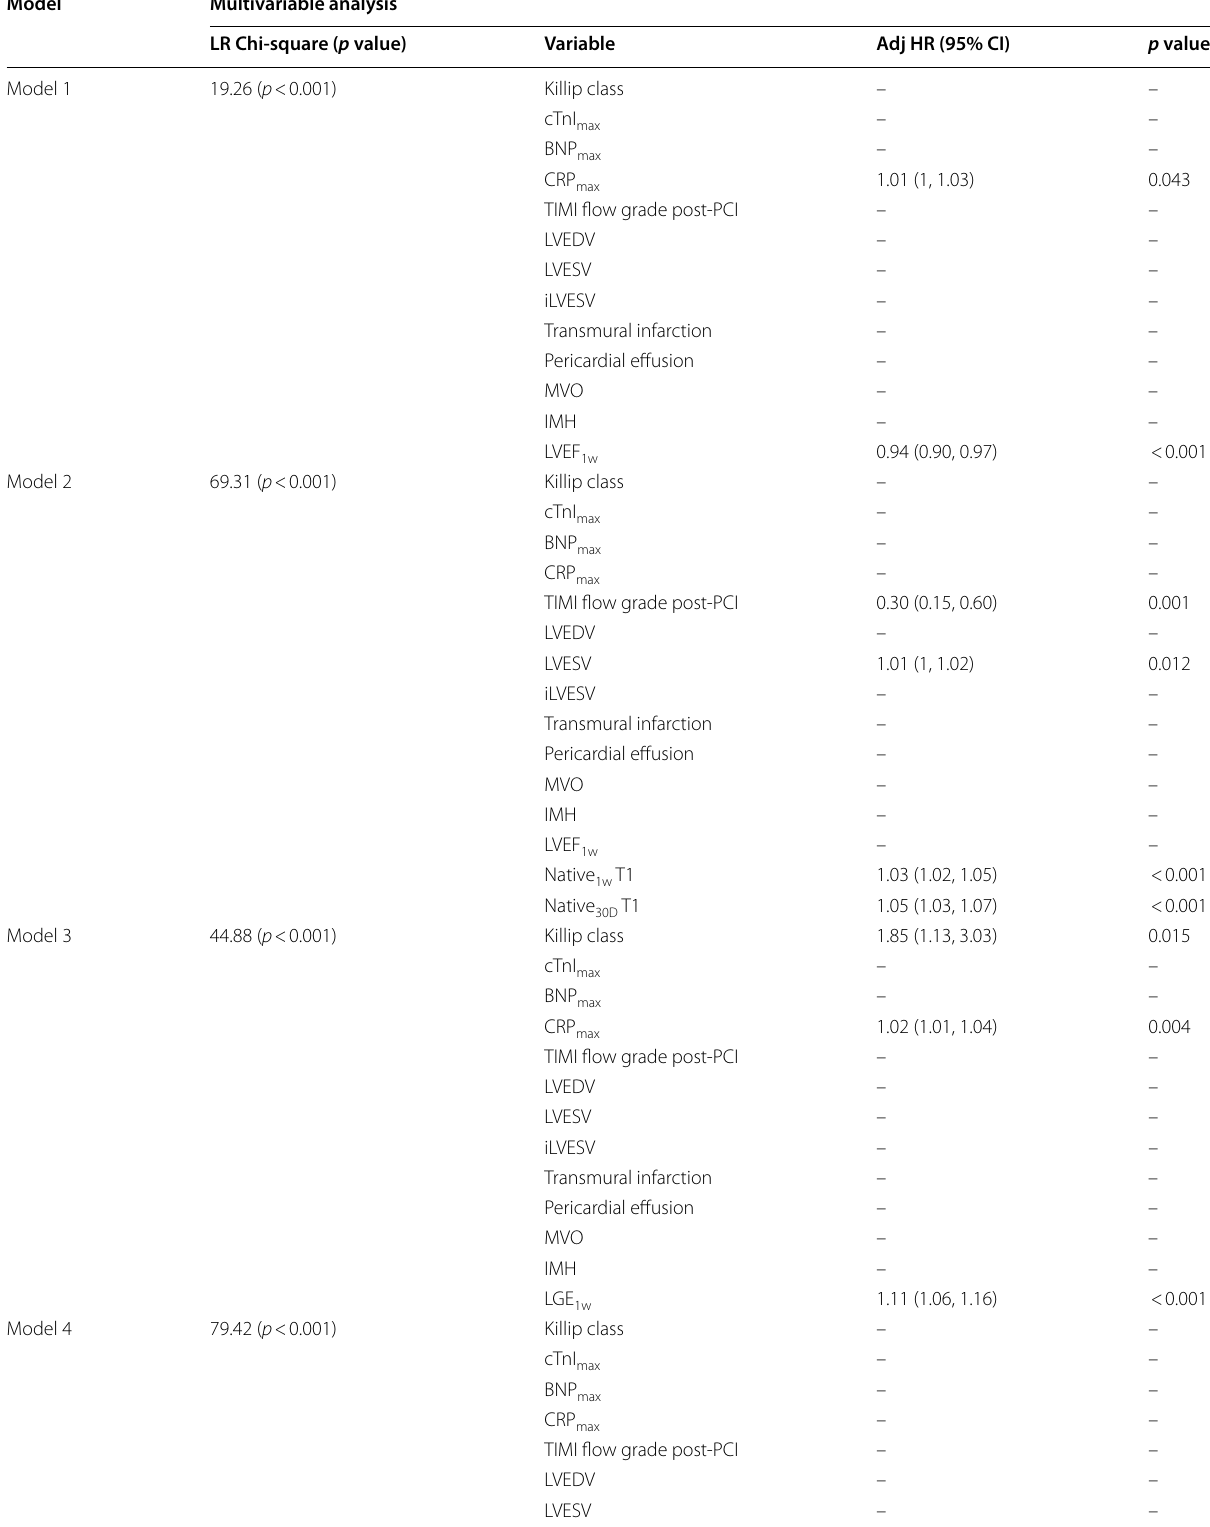
Table 4 Clinical and CMR predictors of MACE in multivariable cox regression analysis for all